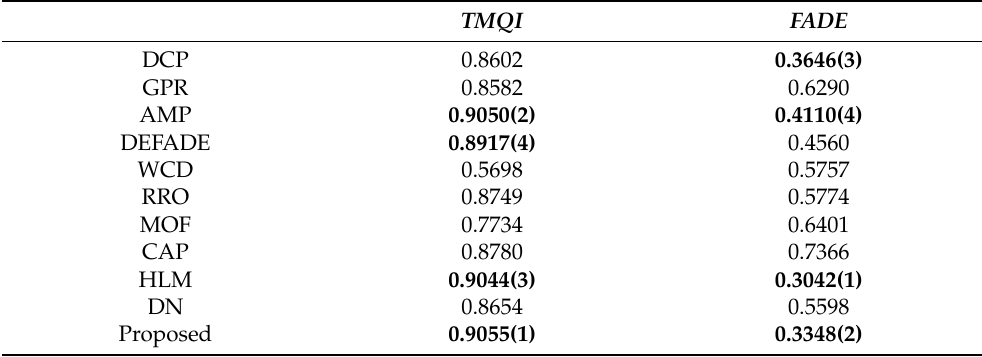
Table 2. Evaluation of three objective indexes in image dehazing experiments of real hazy scenes. The top four results are marked in bold, and the corresponding rank is shown in the parenthesis (1: the best result, 2–4: the 2nd, 3rd, and 4th best results). The higher values of the TMQI index is better, the lower value of the FADE index is better.